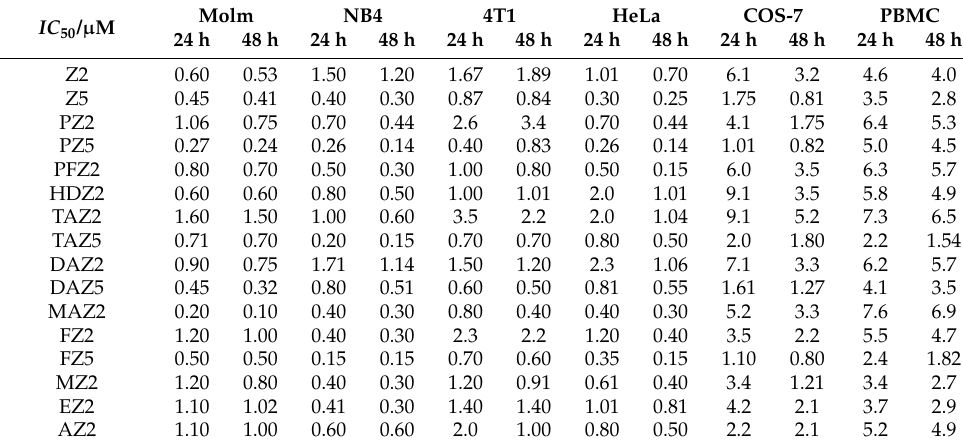
Table 1. The inhibition effect of organic arsenicals in vitro a